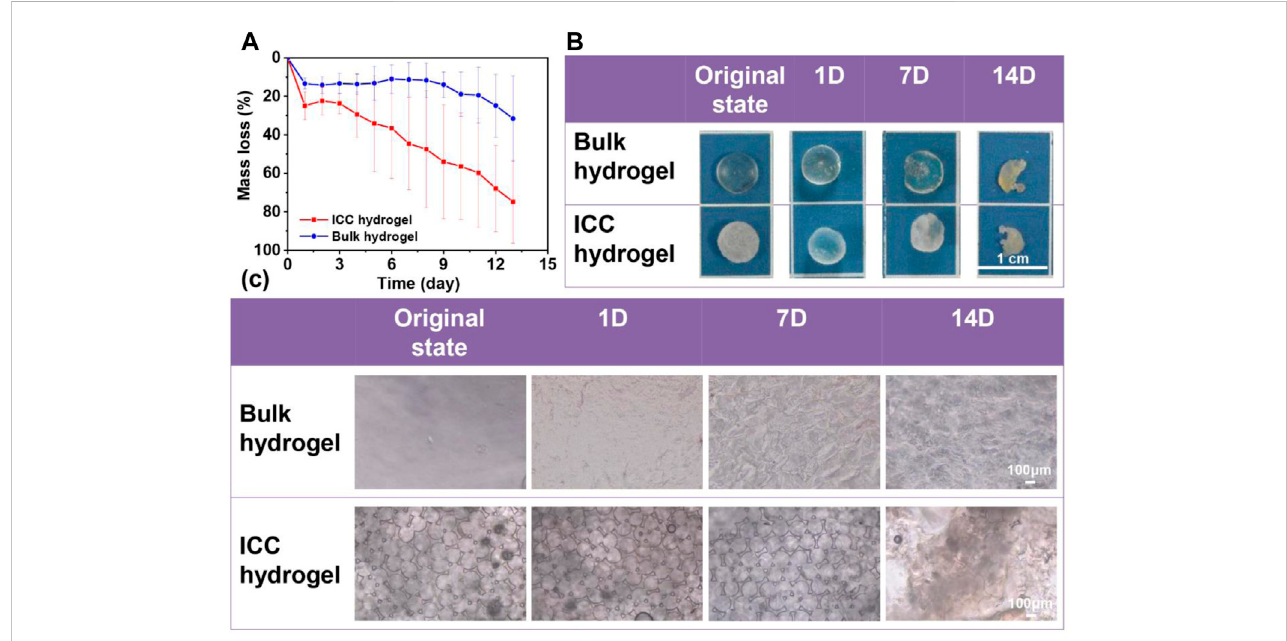
FIGURE 4 (A) MasslossofGelMAbulkhydrogel(redline)andGelMAICChydrogel(blackline)( n =5;Mean±S.D.)( p < .0001,one-wayANOVA, n =5measurements of two samples) (B,C) Gross images and microscopic images of degraded hydrogel samples at the fi xed time points (original, 1D, 7D, and 14D). (For microscopic images taken by 10 × Lens, Scale bar is 100 μ